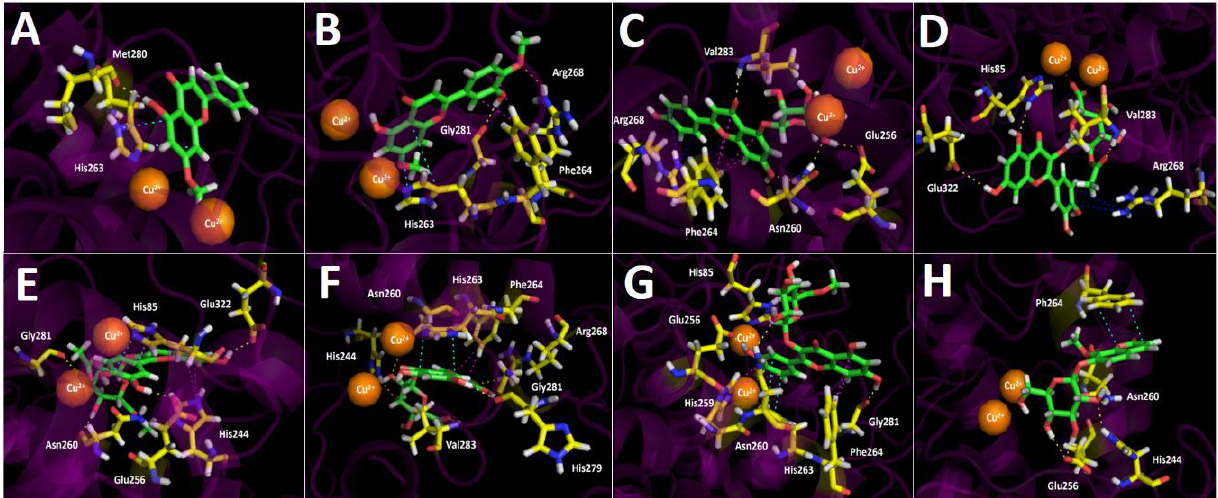
Figure 7. Predicted binding mode and predicted intermolecular interactions of most abundant compounds in O. pillopillo leaves extract and the residues of Torpedo Californica acetylcholinesterase ( Tc AChE) catalytic site. Yellow dotted lines indicates hydrogen bond interactions, cyan dotted lines represents π - π interactions, magenta dotted lines represents T -shaped interactions, blue dotted lines represents π -cation interactions and red dotted lines represents salt bridges. ( A ). 5-hydroxy-7-methoxy-2-phenyl-4 H -chromen-4-one into the catalytic site; ( B ). Luteolin 7, 4′ -dimethyl ether into the catalytic site; ( C ). Apigenin 5-glucoside into the catalytic site; ( D ). Quercetin 3-O-ß -D-2 ″ -acetylglucuronide into the catalytic site; ( E ). Quercetin 3-O-ß-D-2 ″ -acetylglucuronide methyl ester into the catalytic site; ( F ). Quercetin 3-O-(ß-D-glucuronide) into the catalytic site; ( G ). Quercetin 3-O-ß -D-(glucuronide methyl ester) into the catalytic site; ( H ). 8-O-metyl daphnin, (daphnetin 7 O-glucose, 8-methyl ether) into the catalytic site.